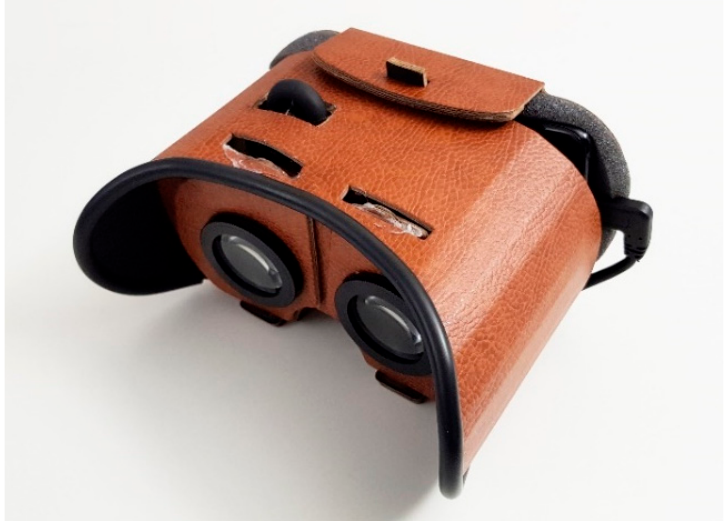
Figure 8. The “Binoculars” prototype.